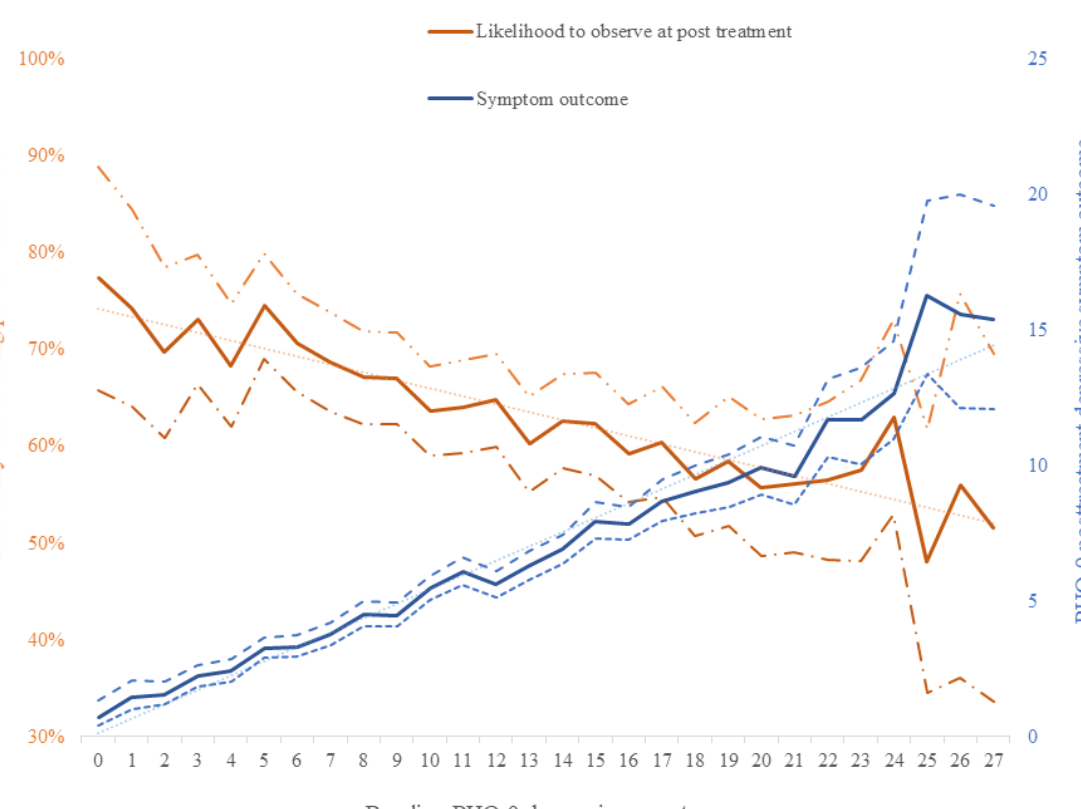
Comparison of Replacement Outcomes From Different Statistical